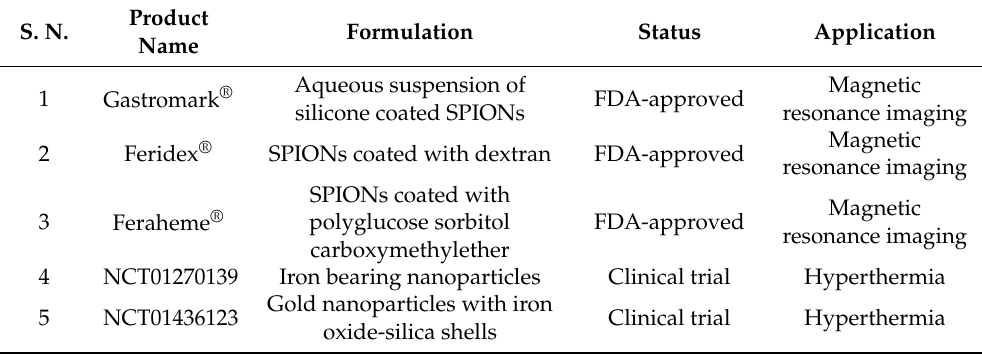
Table 7. Superparamagnetic iron oxide nanoparticles (SPIONs) in use or under clinical trials for cancer therapy. Reproduced with permission from reference